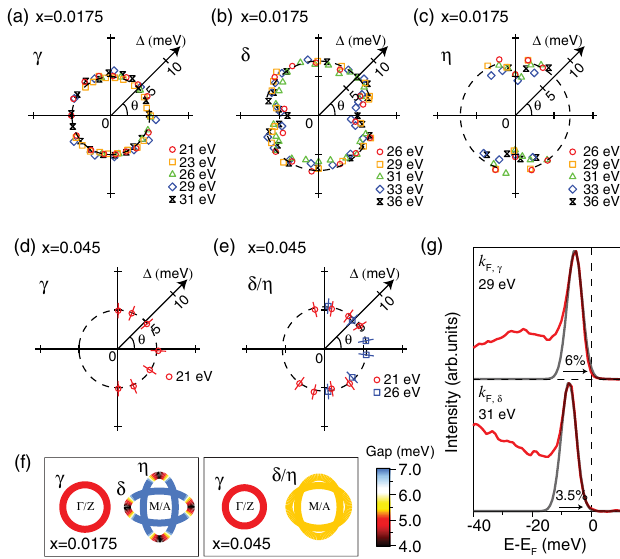
FIG. 4. Polar plots of the SC gap for the (a) (cid:3) , (b) (cid:4) , and (c) (cid:5) Fermi surfaces of NaFe 0 : 9825 Co 0 : 0175 As , respectively. The polar angle (cid:7) follows the same definition as in Figs. 2 and 3. The error bar for the gaps is (cid:5) 1 meV based on the fitting. Polar plots of the SC gap of NaFe 0 : 955 Co 0 : 045 As for the (d) (cid:3) and (e) (cid:4)=(cid:5) Fermi surfaces, respectively. (f) False-color plots of the gap distribu- tion on the Fermi surfaces of NaFe 0 : 9825 Co 0 : 0175 As and Co As . (g) The typical spectra at the Fermi cross- NaFe 0 : 955 0 : 045 ings of the (cid:3) and (cid:4) bands taken at 1 K in BESSY-II. The intensity ratio of the residual spectral weight at E F is referred to the coherence peak height. Two Gaussians with 6 meV full width at half maximum are